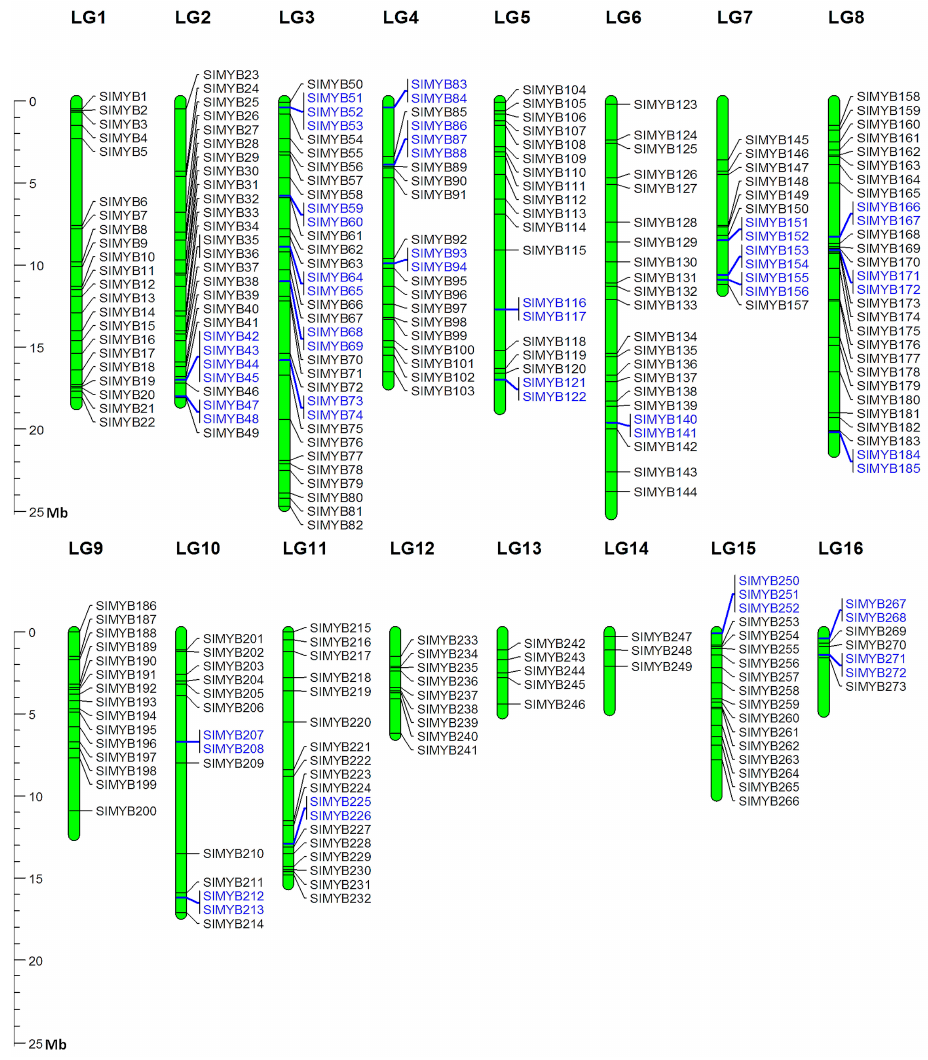
Figure 1. Mapping of sesame MYB genes based on their physical positions. Vertical green bars represent linkage groups (LG) of the sesame genome. The LG numbers are indicated at the top of each LG. The genes colored in blue are the tandemly duplicated SIMYBs . The scale on the left is in megabases